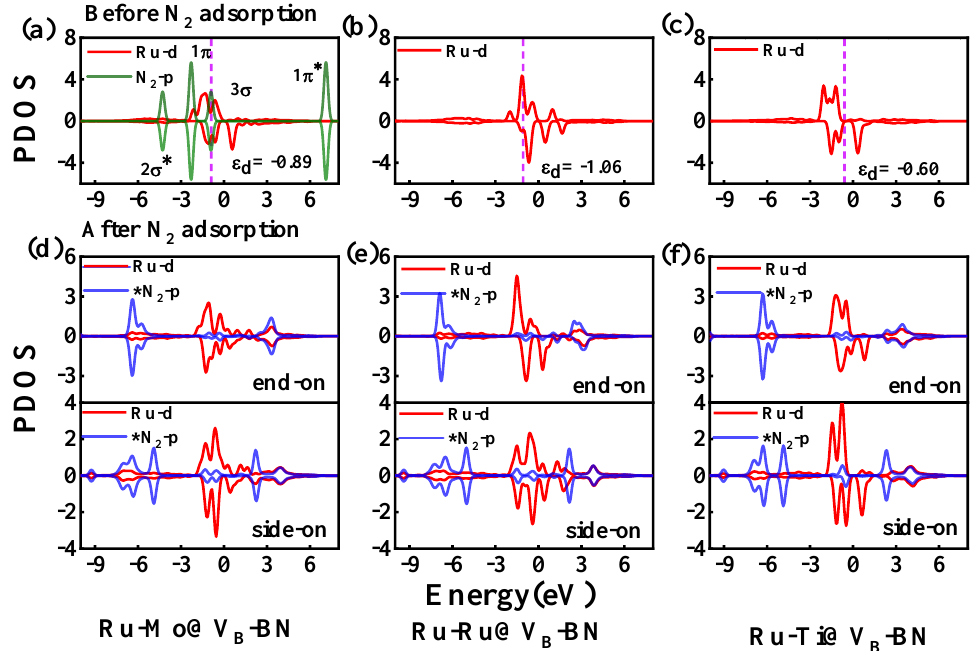
Figure 4. Partial density of states (PDOS) of ( a ) free N 2 molecule and Ru 4 d orbitals in ( a ) Ru-Mo@V B - BN; ( b ) Ru-Ru@V B -BN and ( c ) Ru-Ti@V B -BN before N 2 adsorption. PDOS of N2p and Ru 4 d orbitals in ( d ) Ru-Mo@V B -BN; ( e ) Ru-Ru@V B -BN and ( f ) Ru-Ti@V B -BN after N 2 adsorption in end-on (upper panel) and side-on manner (bottom panel). The purple dashed line represents the corresponding energy level of the d -band center ( ε d ) of the Ru active site, and the Fermi level is set to 0